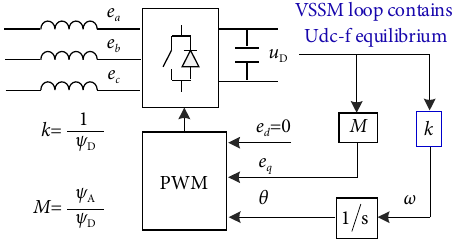
Fig. 3 The VSSM loop contains Udc-f equilibrium.